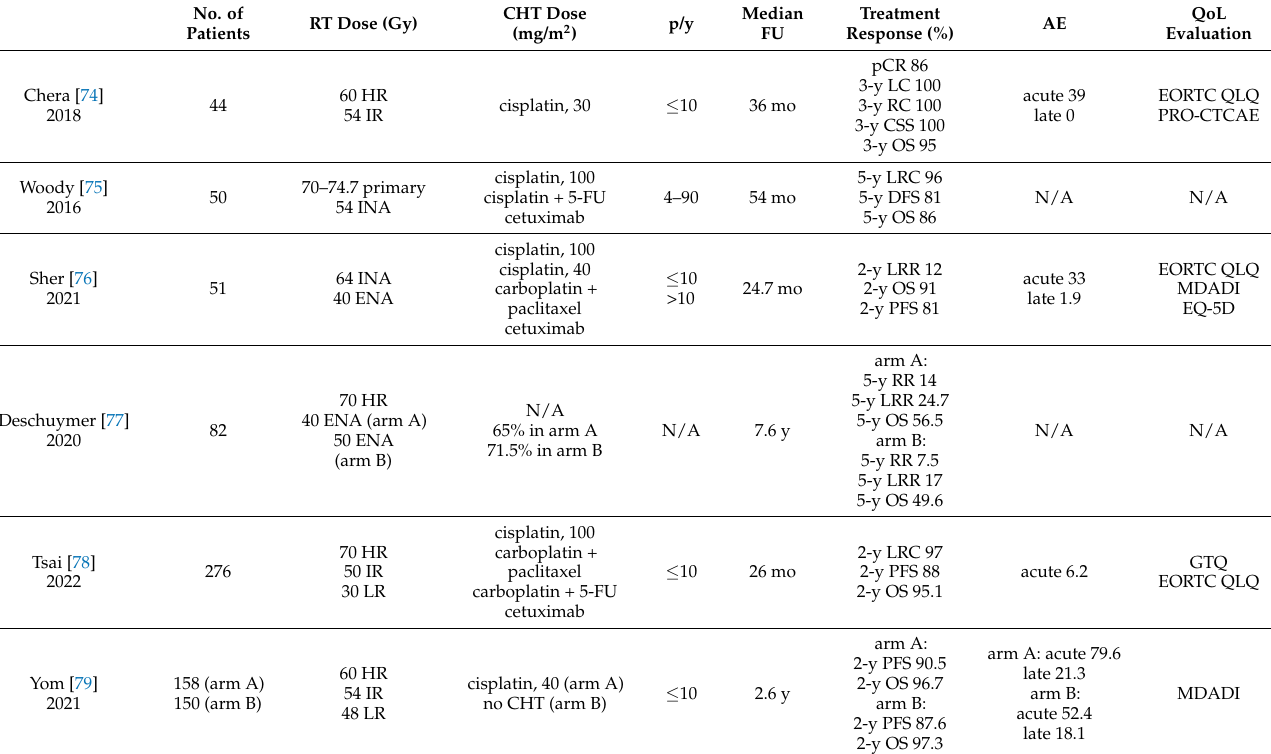
Table 1. Primary de-escalated CRT in the treatment of HPV+